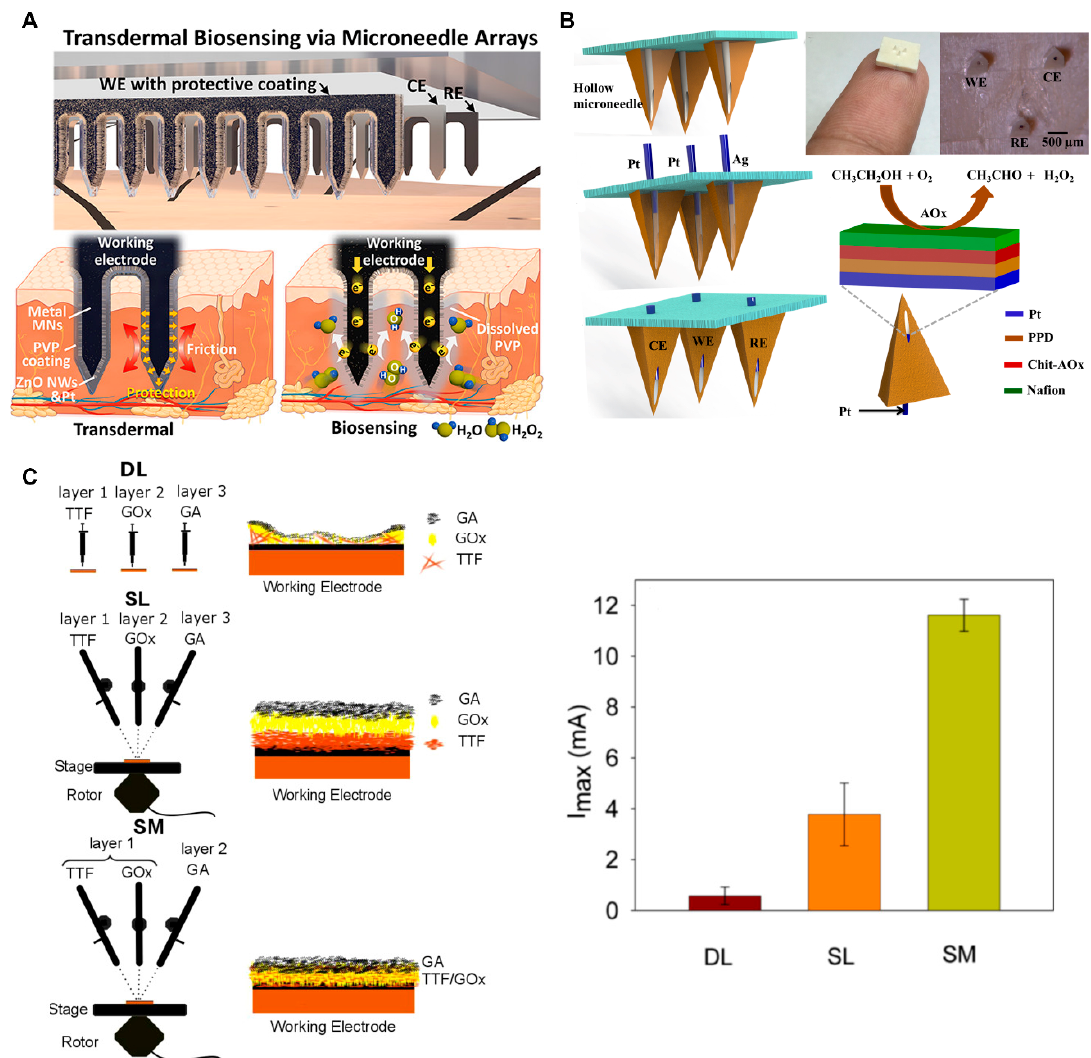
Figure 4. ( A ) Schematic illustration of dissolvable polyvinylpyrrolidone (PVP) layer/ZnO